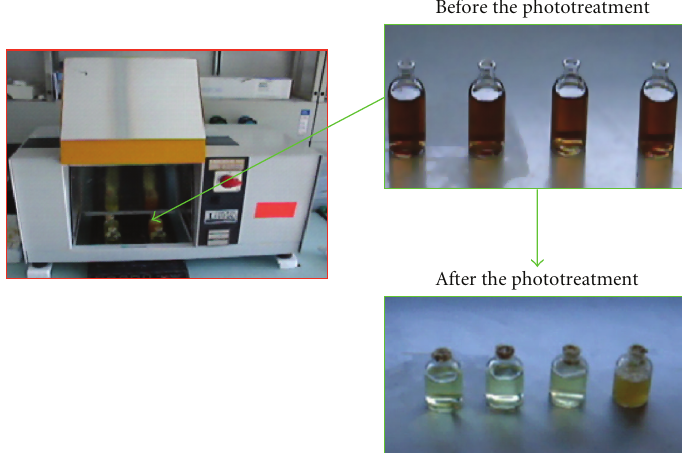
Figure 1: A Hanau Suntest Simulator containing 04 Pyrex flask samples during a laboratory processing at the BE-EPFL, Lausanne, Switzerland.